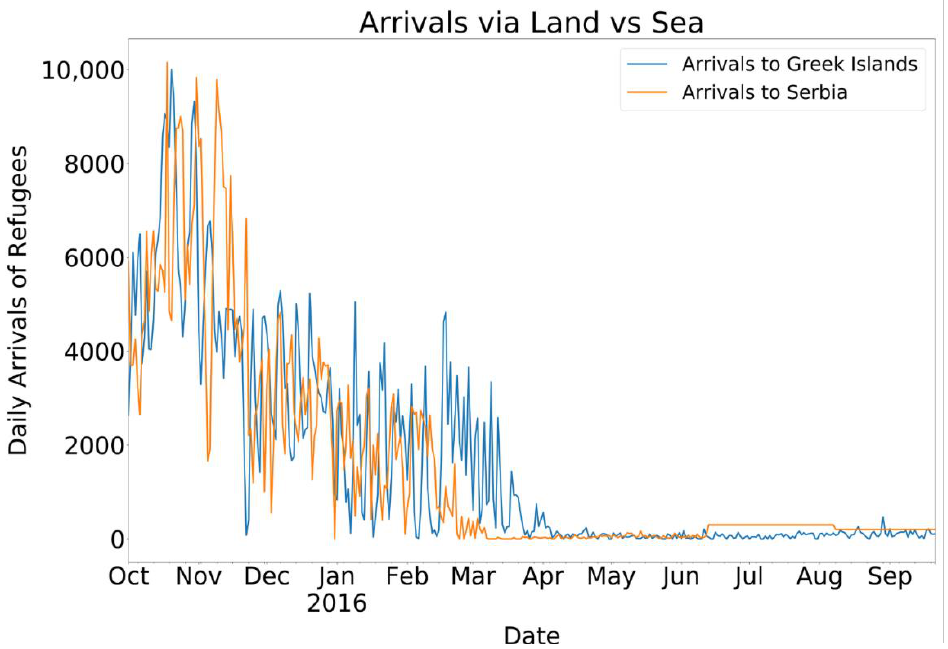
Figure 2. Overview of incoming refugee flows in Greek Islands (representing sea arrivals) and Serbia (representing land arrivals).